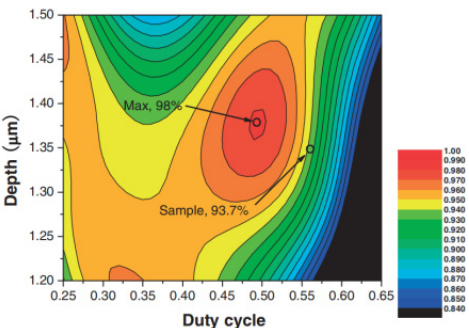
Figure 32. Representative SEM image of the transmission grating.